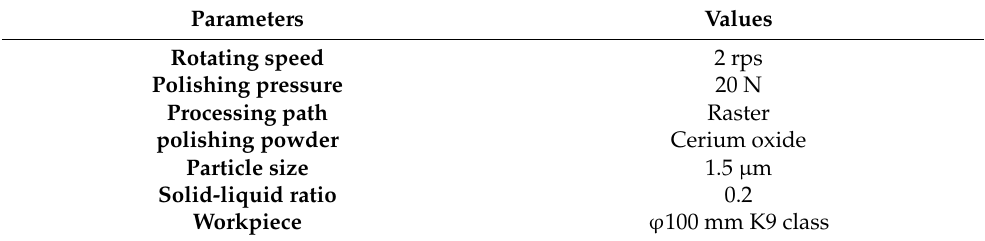
Table 3. Processing